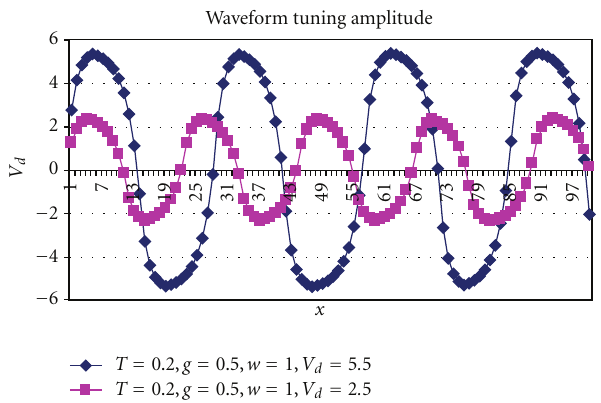
Figure 13: This figure shows the e ff ect of changing the desired value ( V max and V min ) on the